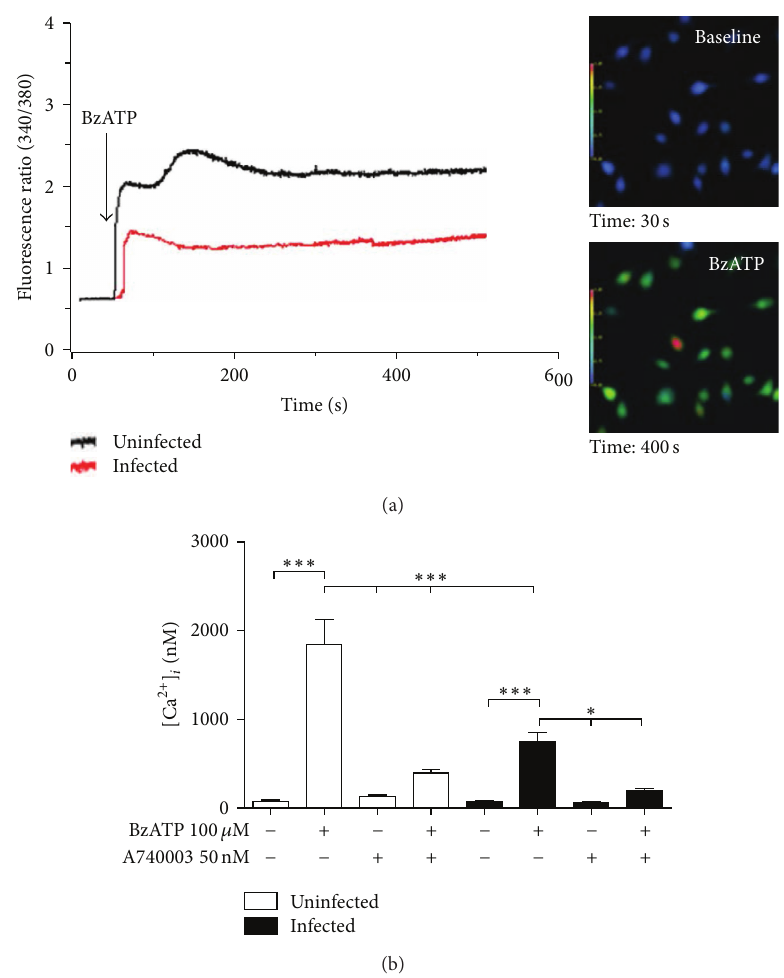
Figure 2: Intracellular Ca 2+ measurement (using Fura-2-AM) in macrophages subjected to treatment with the P2X7 agonist BzATP and/or with the antagonist A740003. (a) Changes in intracellular Ca 2+ levels in macrophages from control (black line) and S. mansoni -infected (red line) mice. Inset: representative images from macrophages (control) before (baseline) and after treatment with 100 𝜇 M BzATP. (b) Changes in intracellular Ca 2+ levels ([Ca 2+ ] 𝑖 ) in macrophages from control (white bars) or S. mansoni- infected (black bars) mice. Three plates were used for each condition/animal, 10 cells/plate were chosen randomly for imaging, and cells were obtained from three animals. Data were expressed as mean and SEM. ∗ 𝑃 < 0.05 ; ∗∗∗ 𝑃 < 0.001 (one-way ANOVA followed by post hoc Newman-Keuls